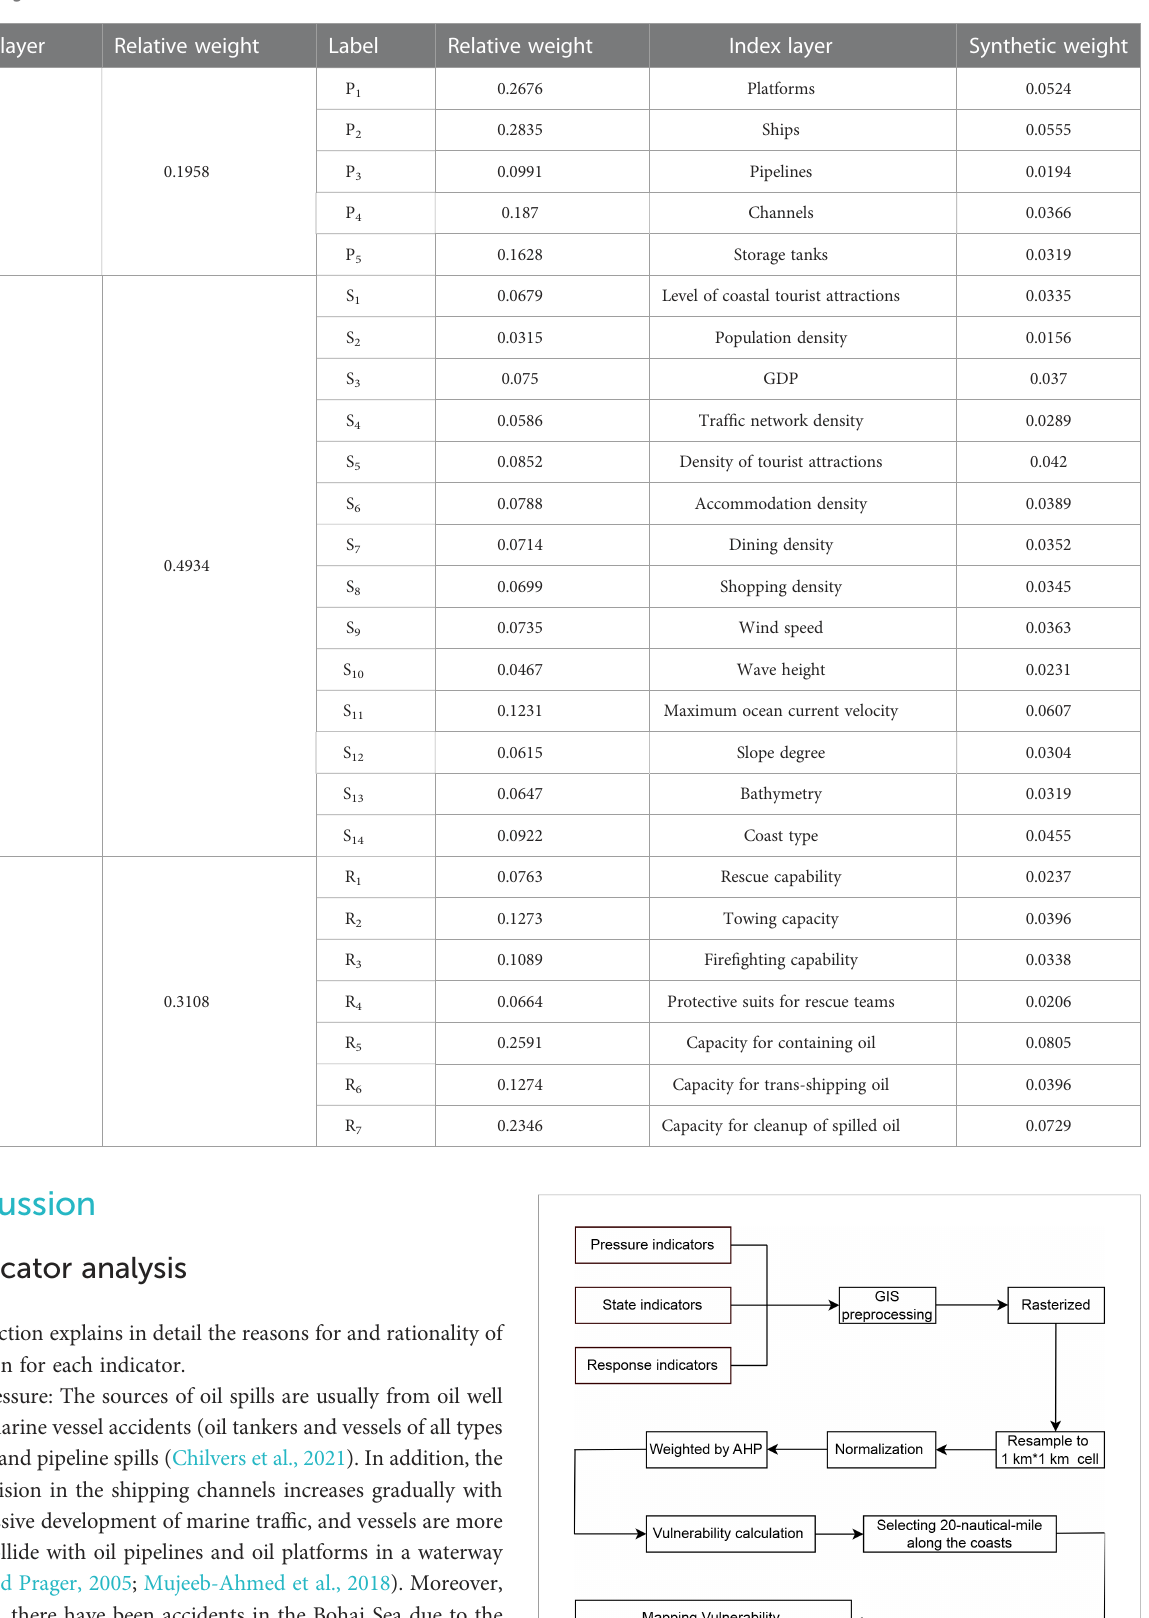
TABLE 5 Weight distributions of all of the indicators.